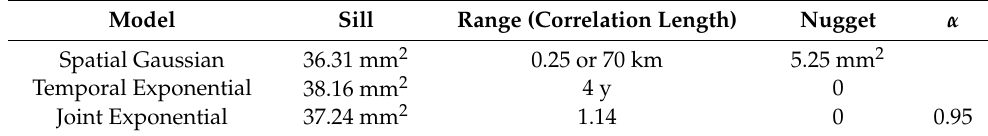
Table 2. Sum-metric variogram models and paraments.